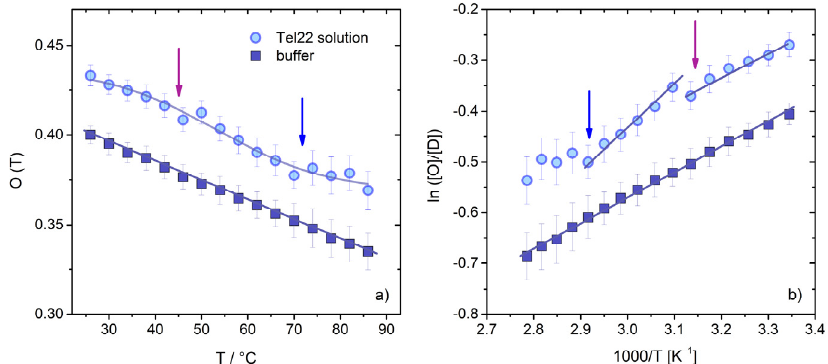
Figure 4. ( a ) Temperature evolution of the parameter O(T), which is the ratio between the area of the OH stretching component at a lower wavenumber, I ν OH1 (T), and the total area of the OH stretching band, I OHtot (T). Circles are the results for Tel22 solution, squares for the buffer. Two inflection points were identified for Tel22 data at about T’ m1 = 44 °C and T’ m2 = 73 °C; the continuous line is only a guide for the eye. ( b ) Van’t Hoff plot for the O ↔ D equilibrium for the Tel22 water solution at 45 µ M at ambient temperature, and the corresponding buffer. The quantity O/D was defined as the ratio O/(1-O) as described in the text. Arrows are guides for the eyes, approximatively corresponding to T’ m1 and T’ m2